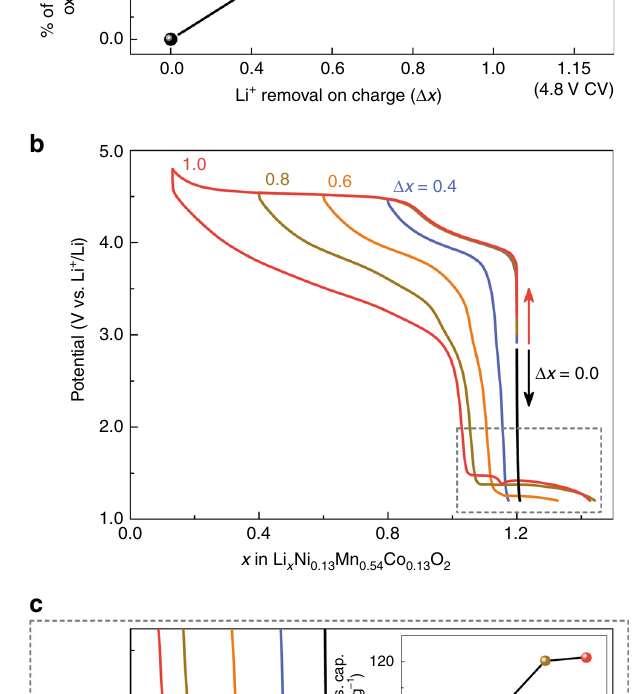
quanti fi ed from XPS are, respectively, plotted as a function of Δ x in